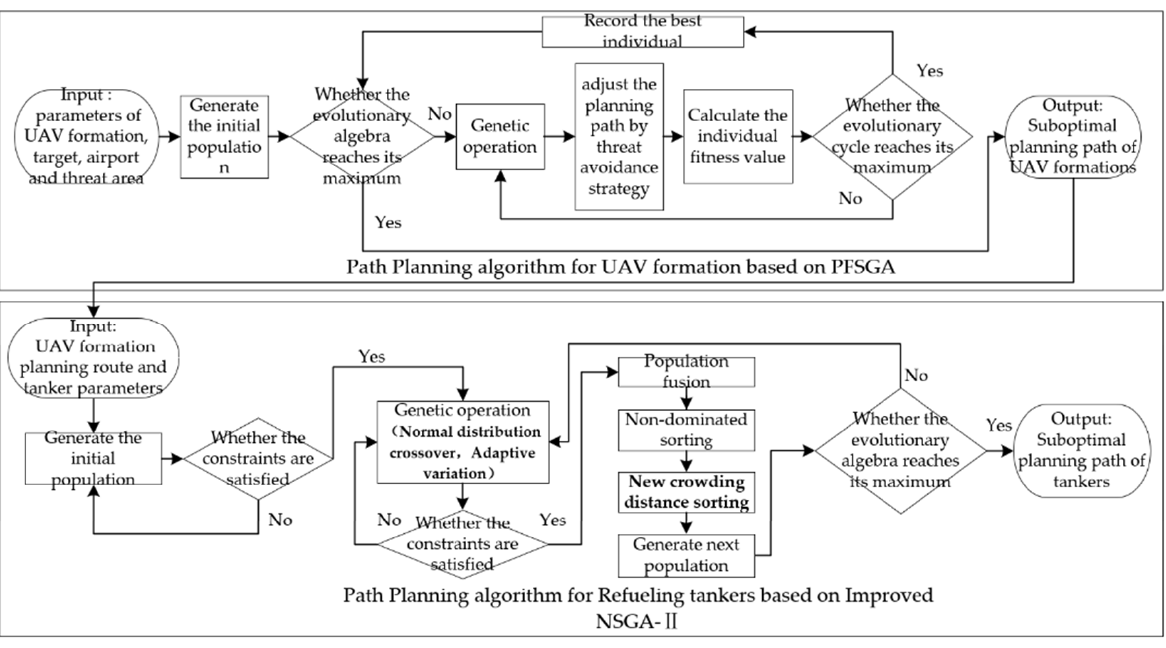
Figure 6. Framework of the two-stage solving algorithm.